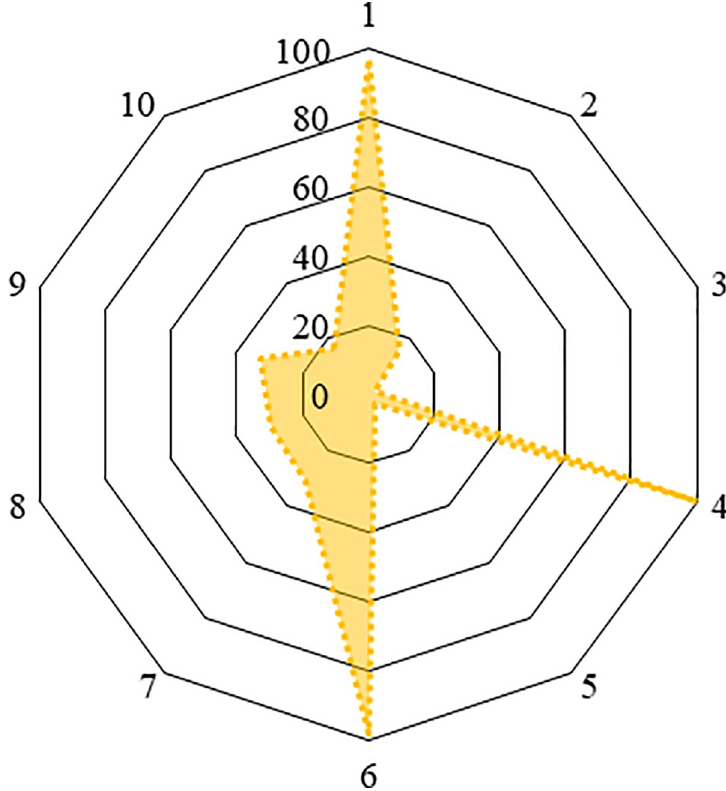
Fig 3. Distribution of appropriate practices among cattle handlers for various questions of the study questionnaire. [(1) What type of milk do you prefer to drink? (raw or unboiled/boiled/both), (2) What do you do when your cattle have been suspected for bTB/zTB? (consult with vets/paravets and do accordingly, sold in market for human consumption), (3) Do you practice separation of TB suspected animals from the healthy animals on your farm? (Yes/No), (4) What type of treatment do you receive if you are infected with zoonotic TB? (modern/ traditional/ religious believes), (5) Do you use any protective equipment (mask, gloves, gumboot and apron) while working on the farm? (Yes/No), (6) Do you practice daily cleaning and sanitation practices (regular cleaning cow dung, washing floor, manger, drinker with detergents) on your farm? (Yes/No), (7) Do you smoke or drink or eat food during the handing animals on the farm? (Yes/No), (8) Do you wash your hands and take a shower immediate after working in dairy farm? (Yes/No), (9) Who provides veterinary health care facilities? (Unskilled veterinary practitioner/farmer himself/Para vets/Vets) and (10) Do you share the same premises (where you are living) with animals? (Yes/ No)].